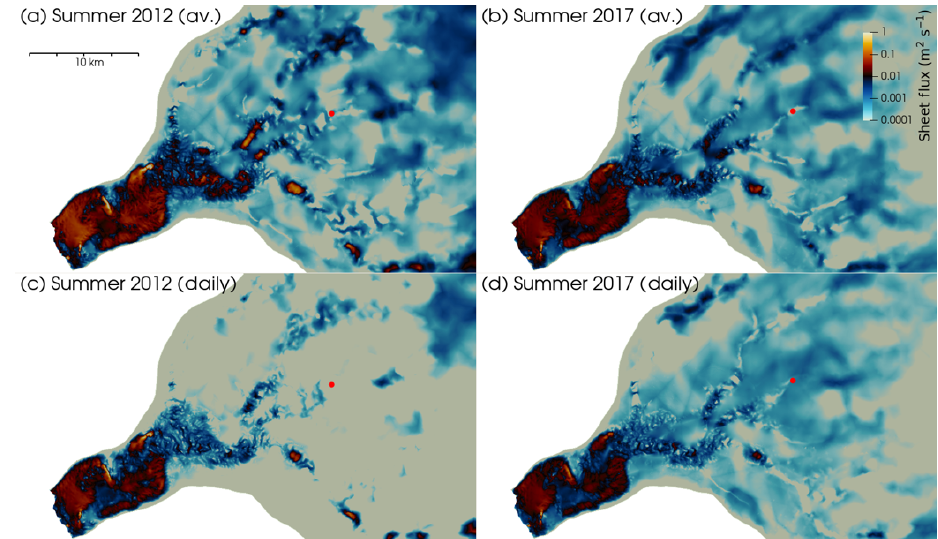
Figure 6. Summer distributed sheet layer at Store. (a) SummerAverage12 model run; (b) SummerAverage17; (c) SummerDaily12; (d) Sum- merDaily17 (red dot shows S30 study site from Young et al., 2019). All the panels show the sheet layer at the end of the respective simulations, after 3 months of surface melting. The daily-forced runs show a less extensive sheet owing to declining surface melt towards the end of the melt